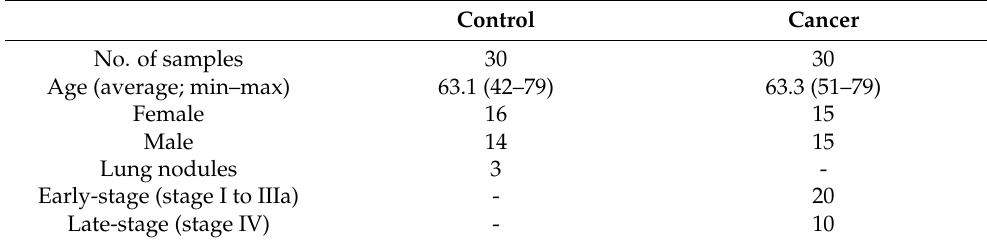
Figure 2. Wet and dry lab workflow for the study of mRNA and circRNA derived from blood platelets using nCounter technology. Total RNA is extracted from human platelets and directly hybridized with nCounter probes. Hybridization and purification are performed on the nCounter prep-station and counting of the hybridized barcode is performed on the nCounter digital analyzer. Bioinformatic workflow consists of quality control (QC) and data filtering, normalization of counts, differential expression (DE) analysis, and the generation of a prediction model through the use of ML algorithms. Table 1. Data table with the general characteristics of sample cohort (non-cancer individuals and lung cancer patients) including the number of samples, age, sex, and clinical information employed for the analysis with both human immunology v2 and 78-circRNA custom panel using nCounter